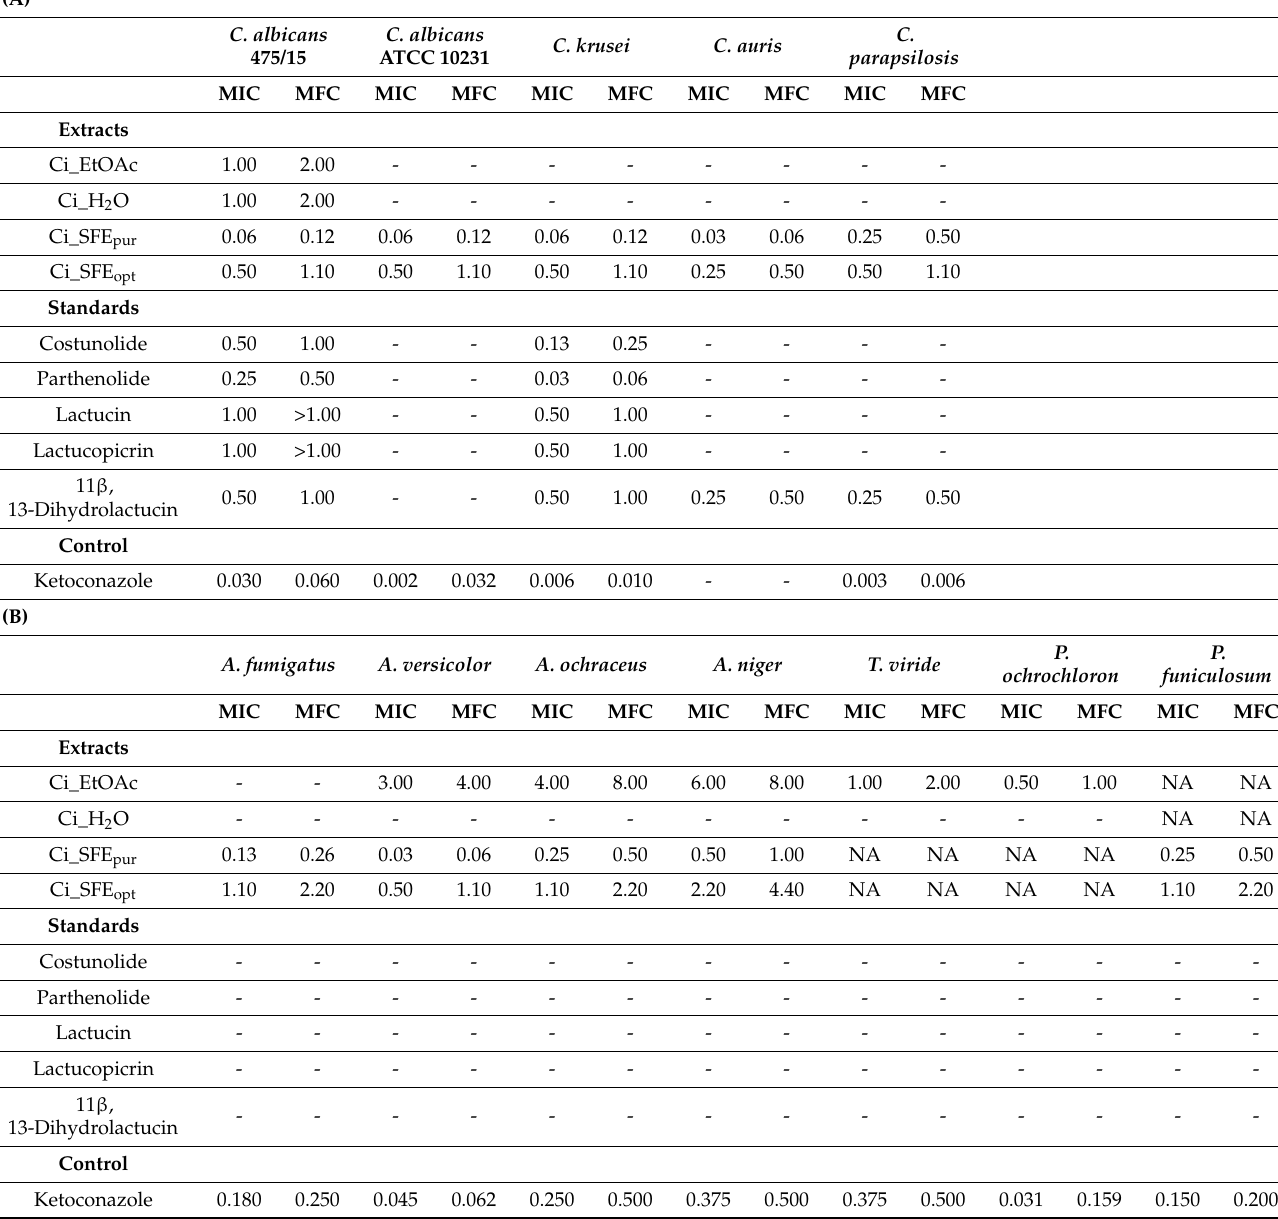
Table 5. Antifungal activity of terpene extracts and pure compounds against ( A ) selected Candida species/strains and ( B ) selected other fungal pathogens. MIC, minimal inhibitory concentration; MFC, minimal fungicidal concentration (mg/mL). NA, not